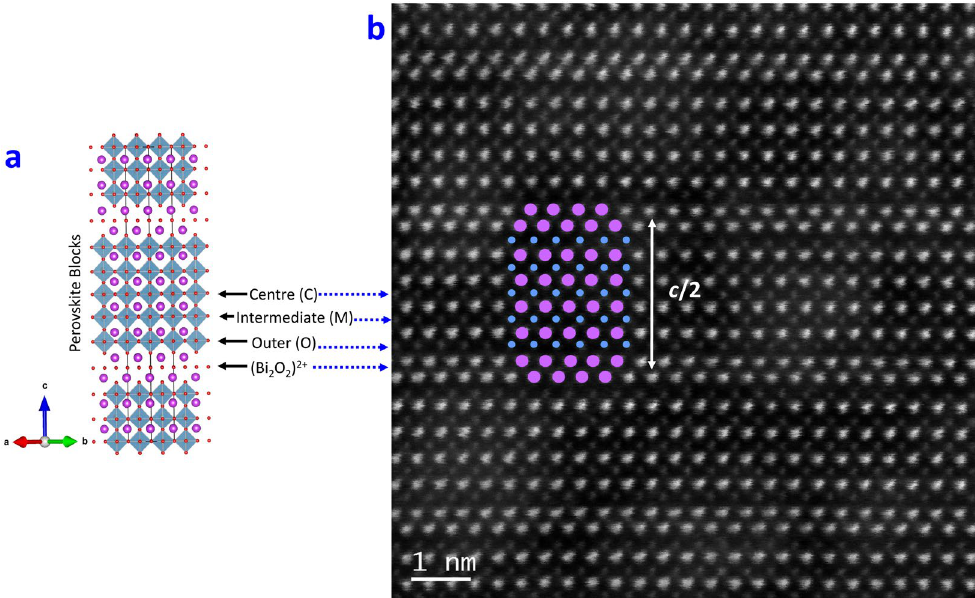
Figure 1. ( a ) Schematic of a five-layered Aurivillius phase structure 19 , illustrating layered intergrowths of fluorite-like [Bi 2 O 2 ] 2 + units alternating with perovskite-like units having Bi cations at the A-sites (purple) and transition metal cations at the B-sites. BO 6 octahedra are displayed in blue and oxygen atoms are displayed in red. ( b ) Atomic resolution HAADF-STEM image for B6TFMO. Bi cations are represented by purple circles and transition metals cations (Ti/Mn/Fe) are represented by blue